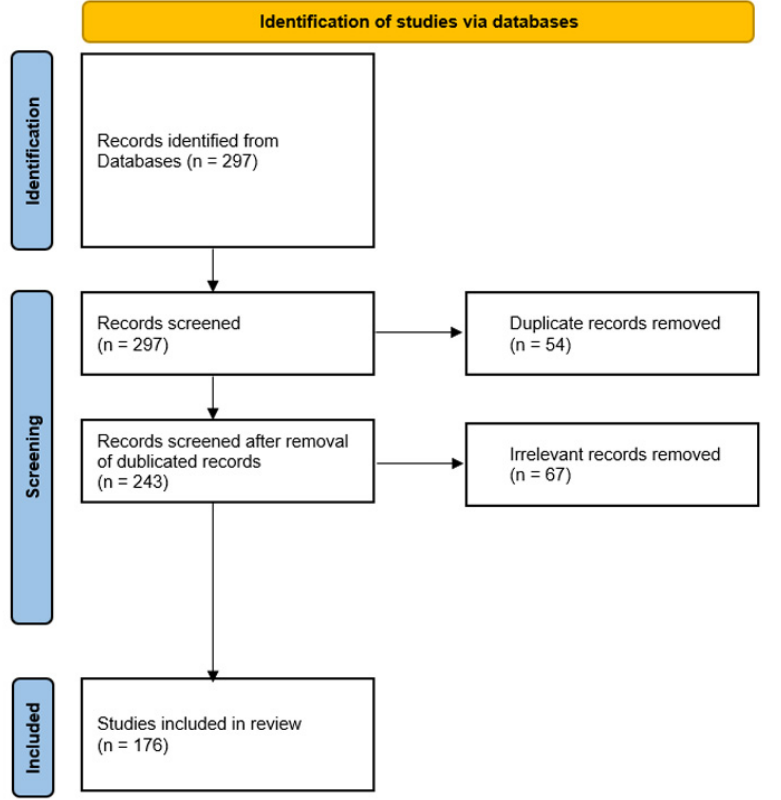
Figure 1. Selection procedure of the